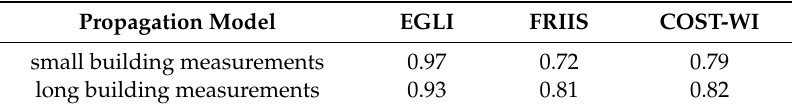
Table 1. Correlation coe ffi cients for propagation models and